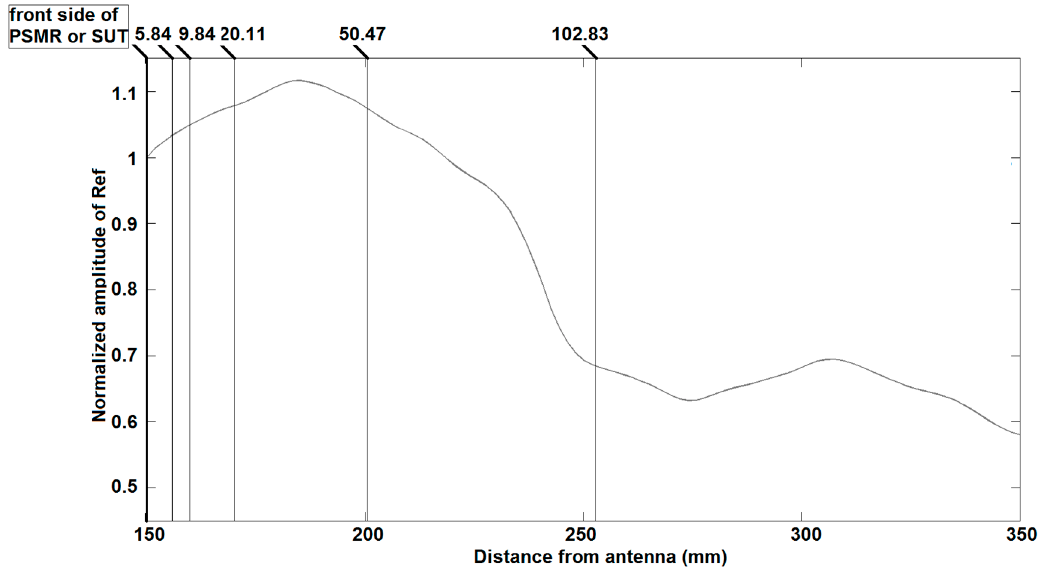
Figure 9. Normalized amplitude of Ref signal versus antenna distance.